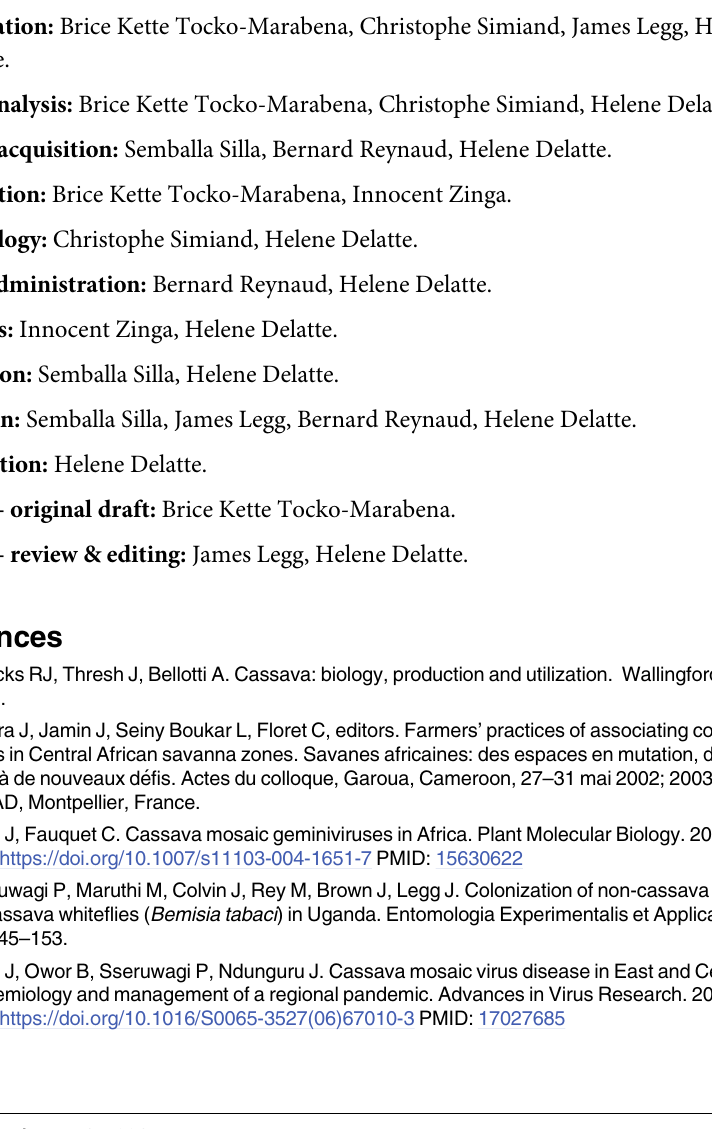
S1 Table. B . tabaci mtCOI sequences used to construct the phylogeny and haplotype net- work. Sequences presented were all of 504 bp and represent 587 samples obtained from Cen- tral African Republic. Nb: Number of each individual